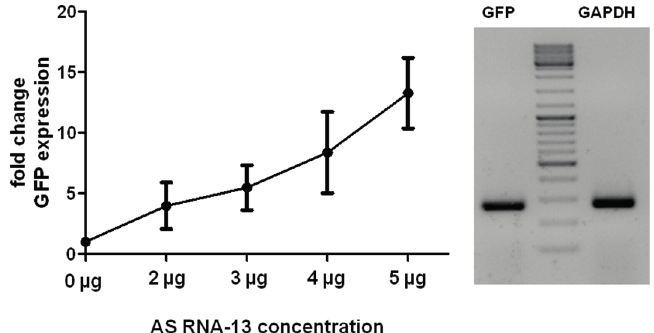
Figure 5. Quantification of full-length GFP transcripts by sqRT-PCR. Co-transfection of AS RNA-13, RTM_31 and COL7A1 -MG-expressing plasmids into HEK293 cells increased the level of trans -splicing. The amount of GFP transcripts, representing accurate trans -splicing events between RTM_31 and COL7A1 -MG, was quantified by sqRT-PCR using GFP specific primers. Similarly to the data obtained by flow cytometric measurements (Figure 3A) the GFP expression correlates with the amount of given AS RNA-13. The more AS RNA-13 expression plasmids were introduced into the cells, the higher was the trans -splicing efficiency manifested in the expression of full-length GFP transcripts. The mean value ± SD of three independent experiments is shown. All values were normalized to